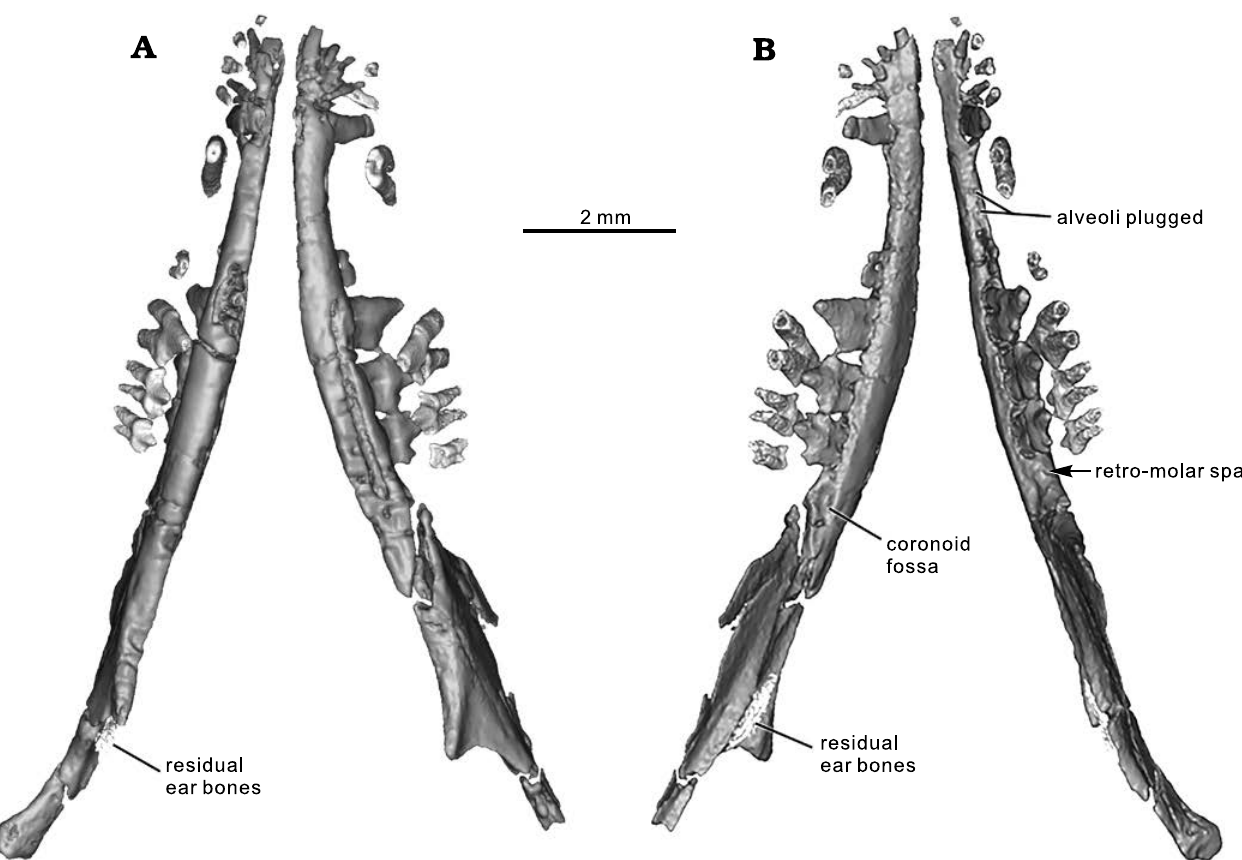
Fig. 4. CT rendering of the mammaliaform Hadrocodium wui Luo, Crompton, and Sun, 2001 (holotype, IVPP 8275) from the Lower Lufeng Formation, Lower Jurassic of Yunnan, China. A . Mandibles and upper teeth (as preserved) in ventral view. B . Mandibles in association with upper teeth in dorsal view. The upper teeth are more inclined (as preserved) and are oblique to the lower teeth. Post-mortem distortion caused the upper postcanines to shift relative to lower teeth, by half a cusp